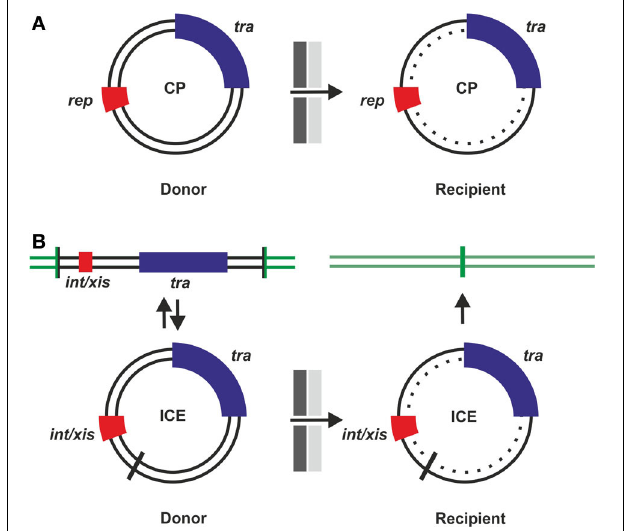
FIGURE 1 | Conjugative plasmids (CPs) and integrative conjugative elements (ICEs). Events leading to horizontal transfer of CPs (A) or ICEs (B) are shown schematically. Before transfer can occur, tra genes must be expressed and a T4SS assembled. After cell-cell contact formation, transfer competent donor cells initiate a rolling circle type replication from circular dsDNA and translocate ssDNA via the T4S machinery into recipient cells. dsDNA is then reconstituted in the recipient (dotted inner circle). (A) CPs can autonomously replicate due to the presence of rep genes. (B) ICEs replicate as integrated elements with the host chromosome (green lines), integration and excision is mediated by int/xis genes required for integration and excision by site-specific recombination via attachment sites (vertical bars). After excision and before integration, ICEs are present in a plasmid-like dsDNA